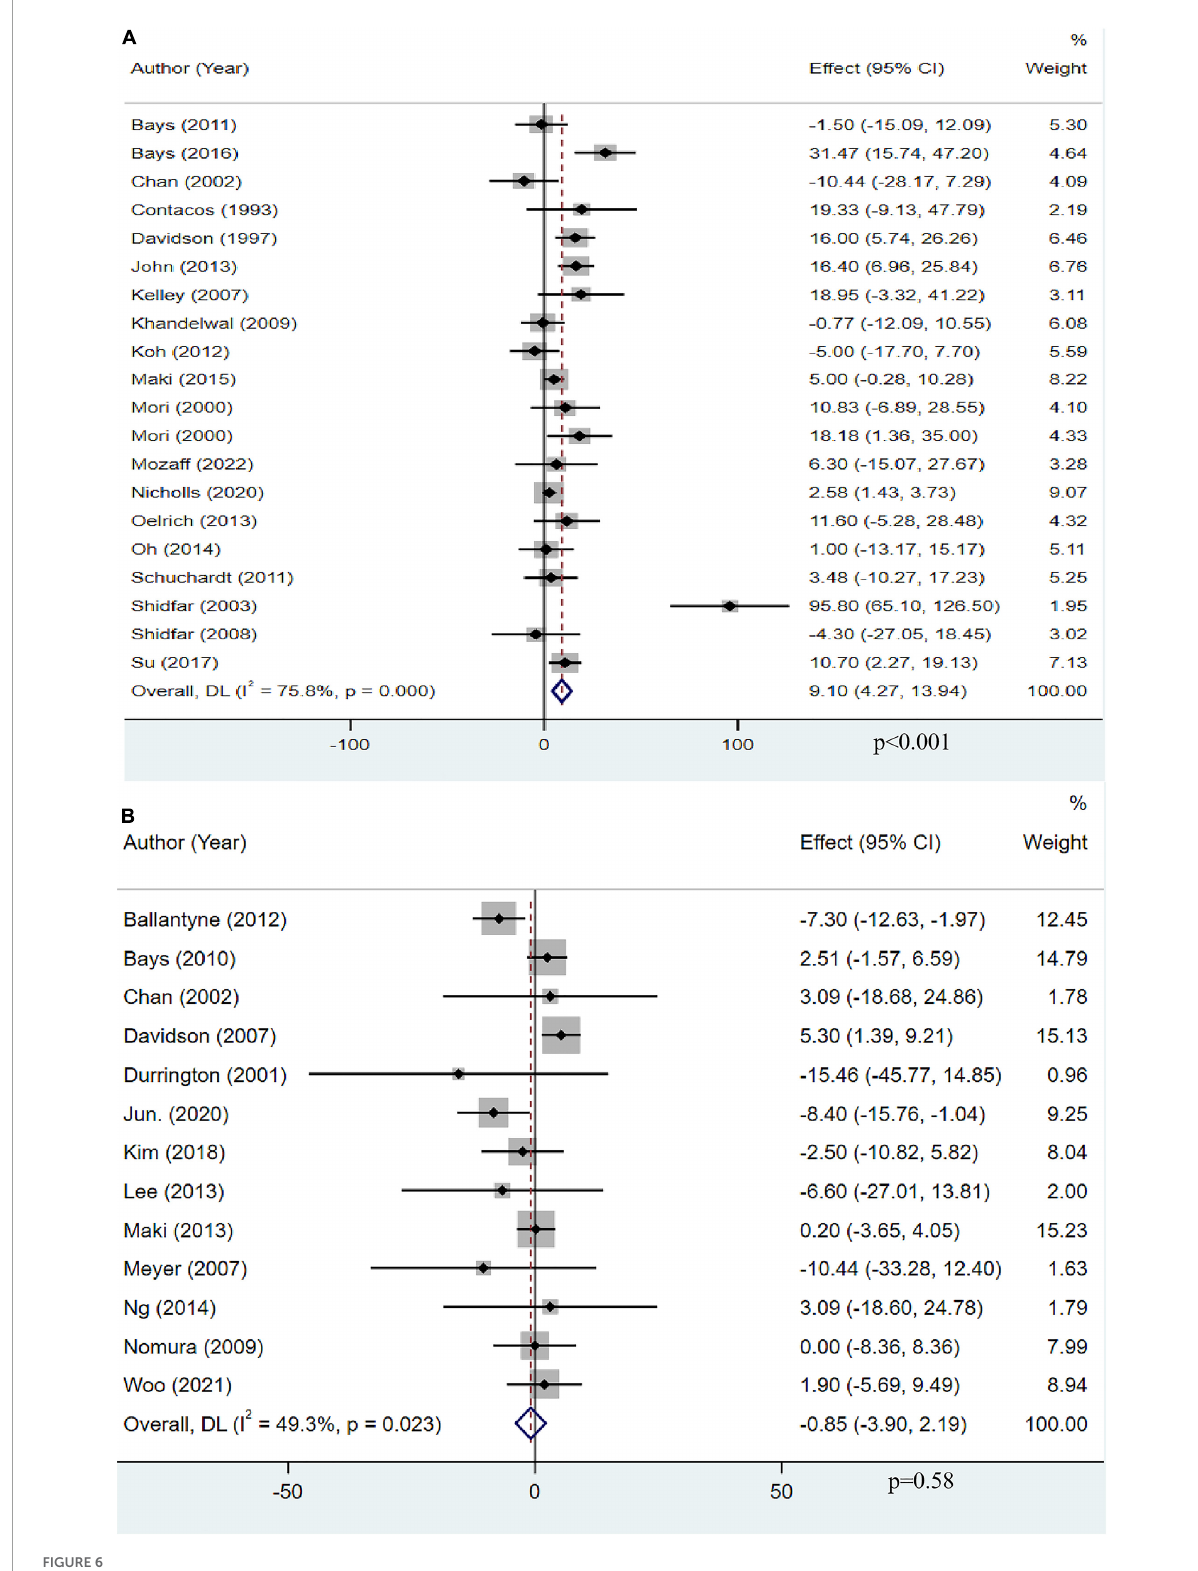
FIGURE6 The effect of OM3-FA on LDL-C. (A) OM3-FA monotherapy; (B) Combined therapy of statins plus